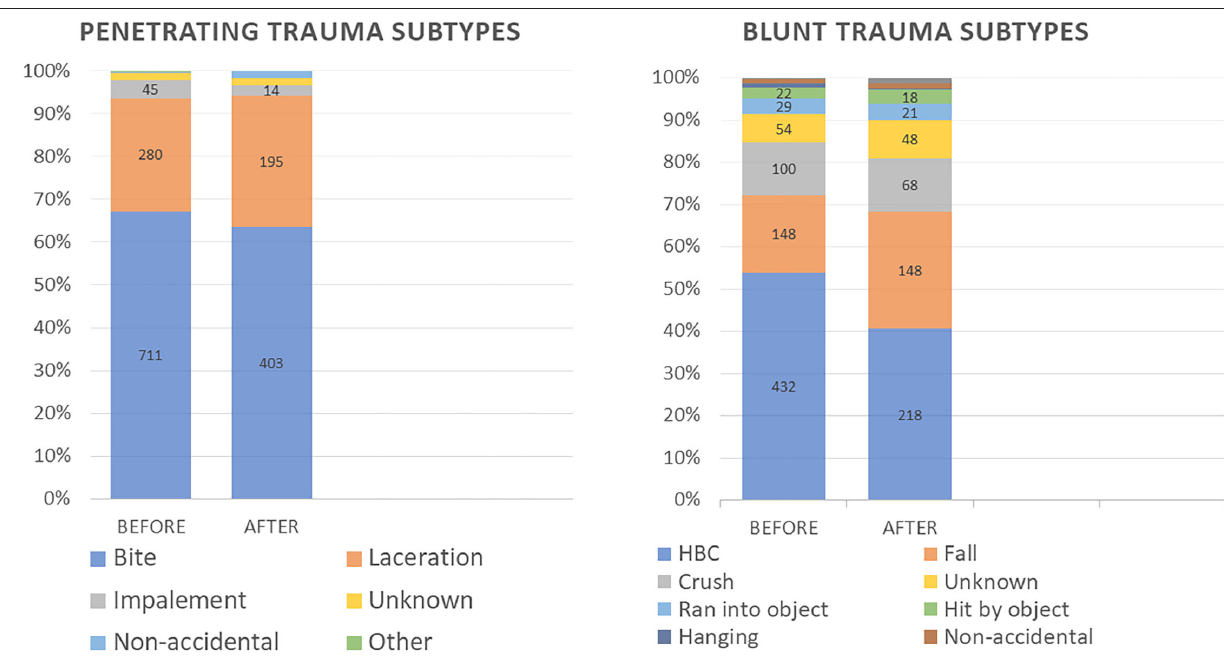
FIGURE 1 | Trauma distribution for all patients before lockdown and after lockdown.